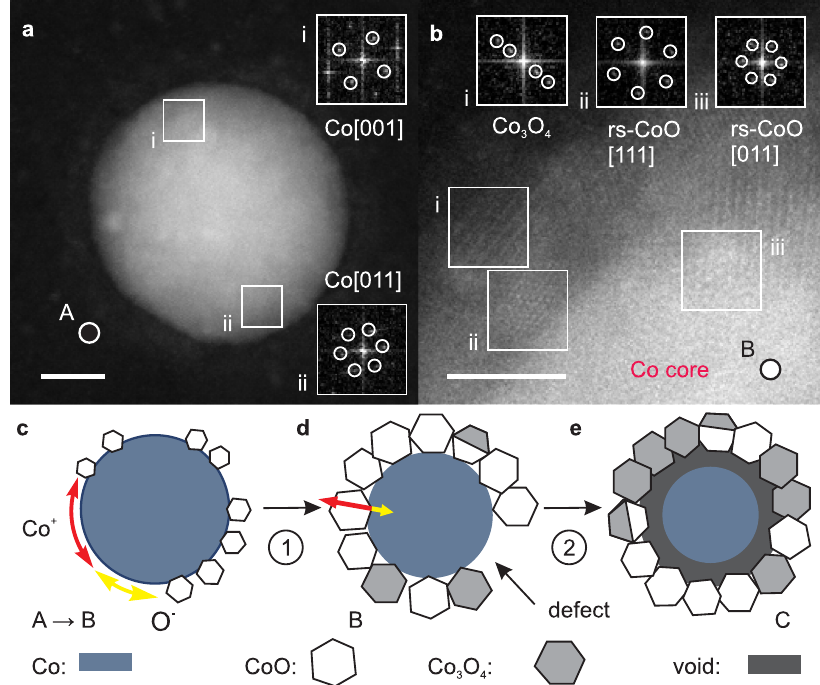
Fig. 4 | Atomic structure and atomistic oxidation model. a High-angle annular dark- fi eld scanning transmission electron microscopy (HAADF-STEM) image of a pure metallic nanoparticle (state A); insets (i) and (ii) show fast Fourier transforms (FFTs)andthededucedzoneaxesoftheareaswiththesamelabelsmarkedbywhite squares (scale bar is 5nm). b Enlarged image with atomic-level resolution of a nanoparticleinstateB;theinsets(i – iii)showFFTsoftheareaswiththesamelabels